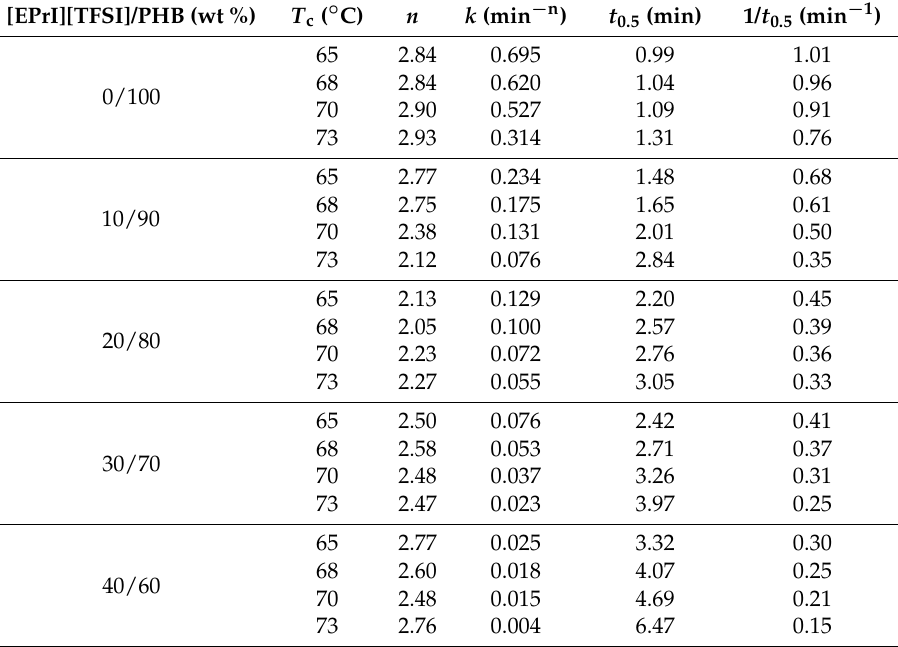
Table 2. Crystallization parameters evaluated by using the Avrami equation for the [EPrI][TFSI]/PHB